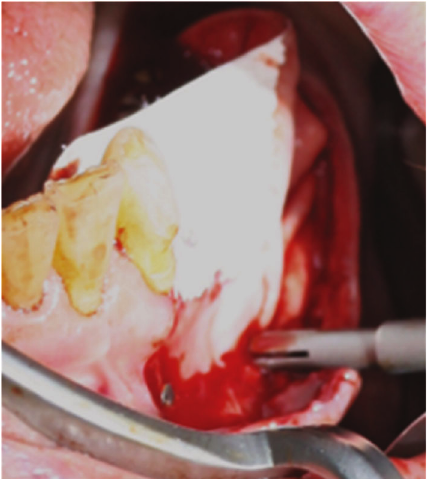
Figure 9: YxOss CBR® titanium mesh screwed onto the bone.